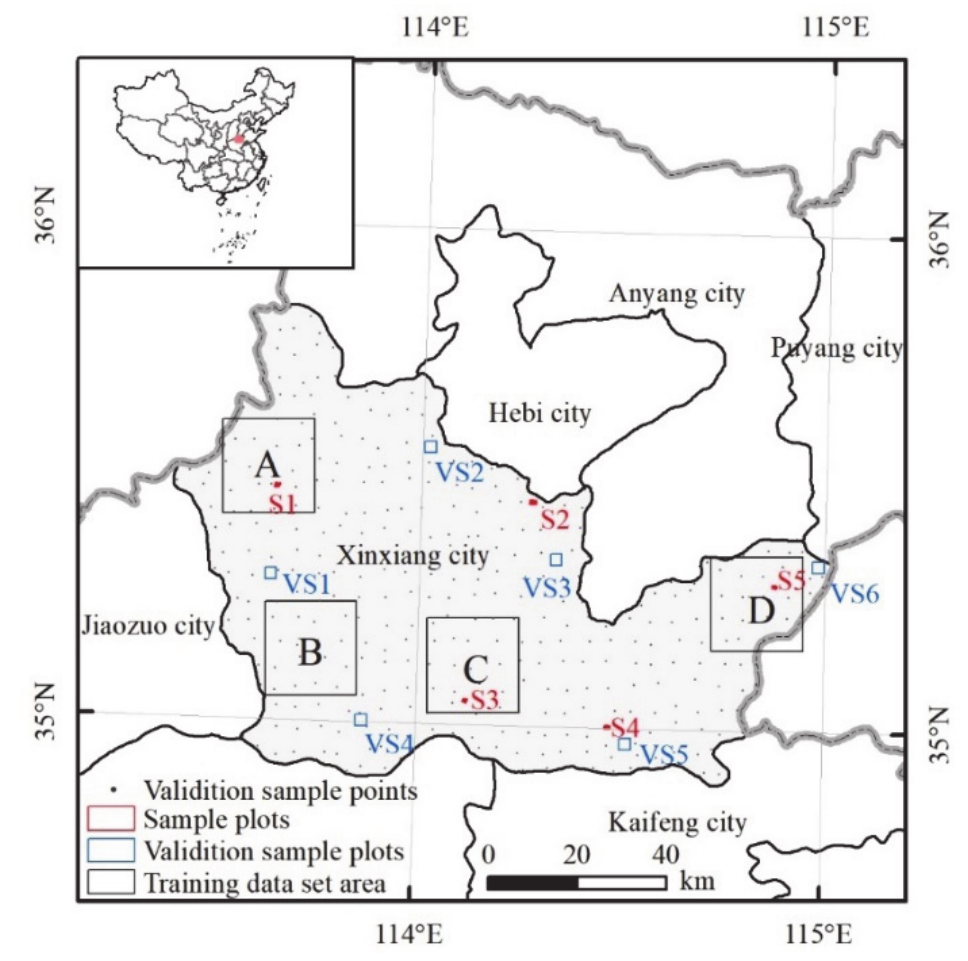
Figure 1. Geography of Xinxiang City on the northern plain of Henan Province, China.